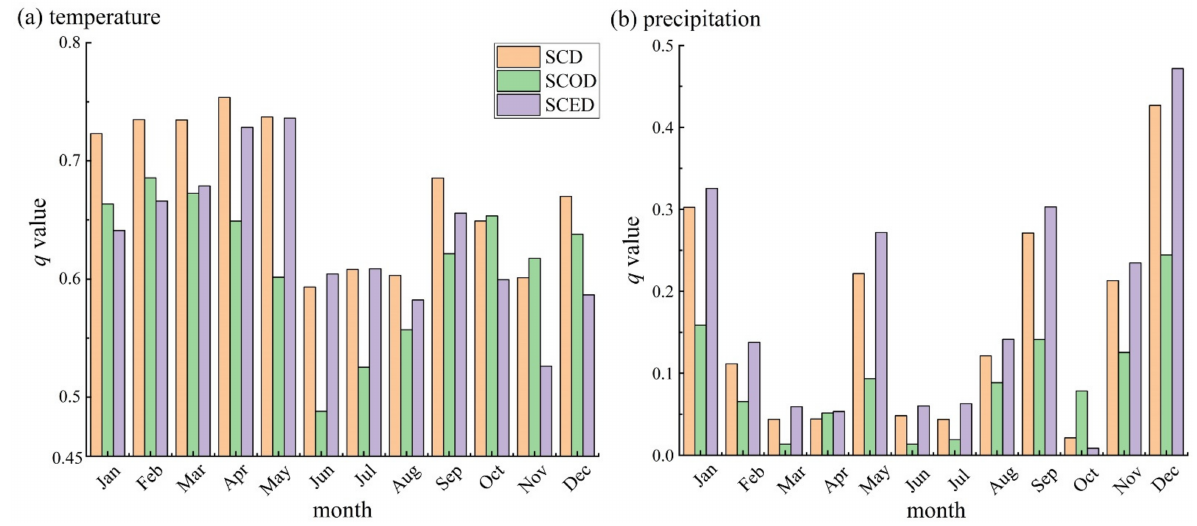
Figure 13. Roles of temperature and precipitation in different months in snow phenology. ( a ) temperature, ( b )